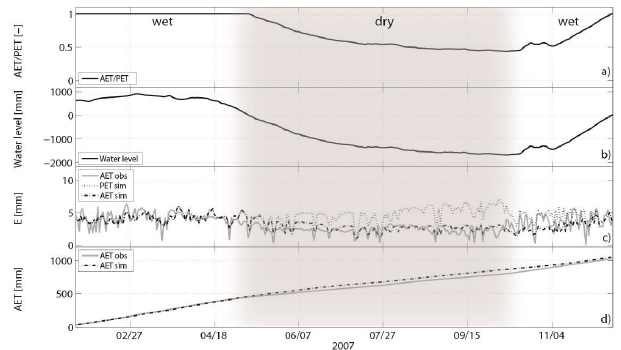
Figure 4. (a) Relative simulated AET to simulated PET at water Figure 4: a) Relative simulated AET to simulated PET at water body C for the dry and the wet 3 body C for the dry and the wet season of the calibration period (26 season of the calibration period (26 January - 10 December 2007); b) Water level at water 4 body C; c) Comparison of simulated AET with simulated PET and observed AET; d) 5 January–10 December 2007); (b) water level at water body C; (c) Cumulative sums of observed and simulated AET 6 comparison of simulated AET with simulated PET and observed AET; (d) cumulative sums of observed and simulated